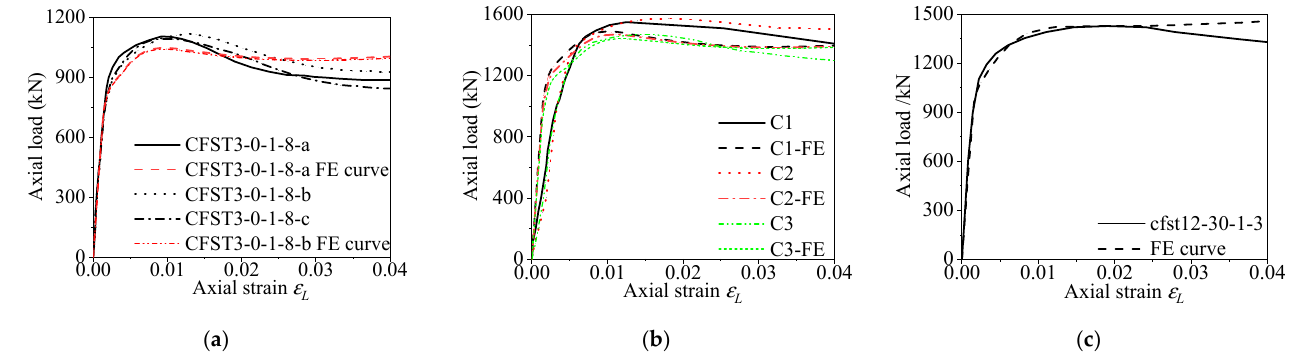
Figure 5. Comparison of FE and experimental load–strain curves: ( a ) reference [38]; ( b ) reference [41]; ( c ) reference [44]. Table 1. Comparison of loading bearing capacity obtained from experimental and predicted results.